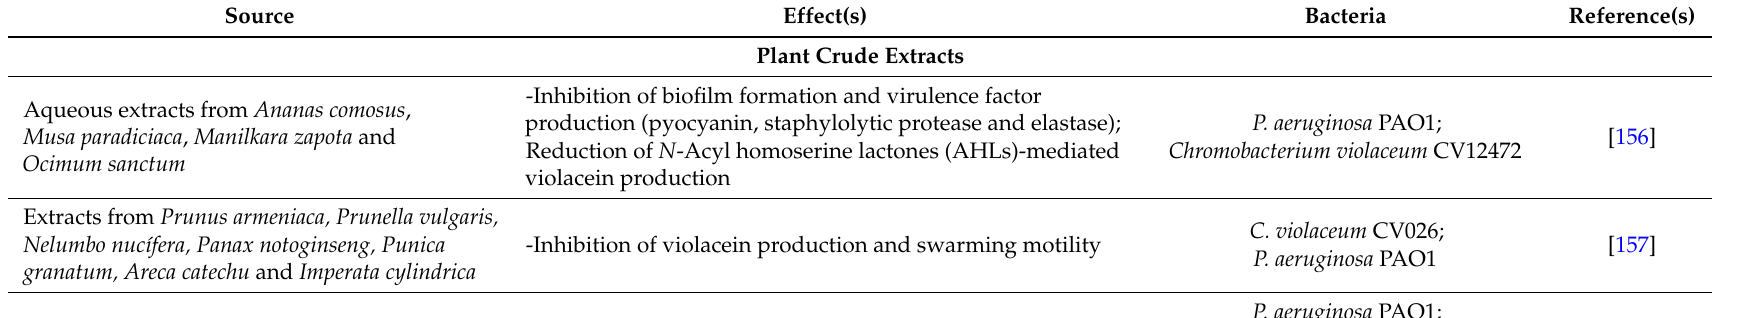
Table 1. Recent studies on QSIs identified from plants and their effect on QS-mediated mechanisms (survey from 2010 to